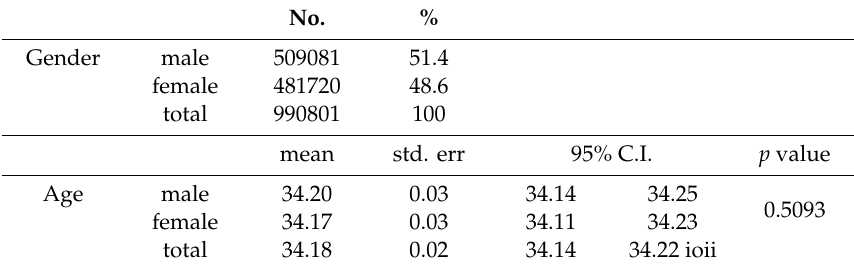
Table 2. Demographics data of random sample from National Health Insurance Research Database.